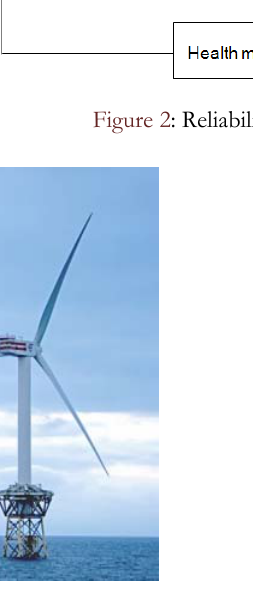
Figure 3: Offshore wind power plant (REpower Systems AG). Figure 4: Offshore oil platform.